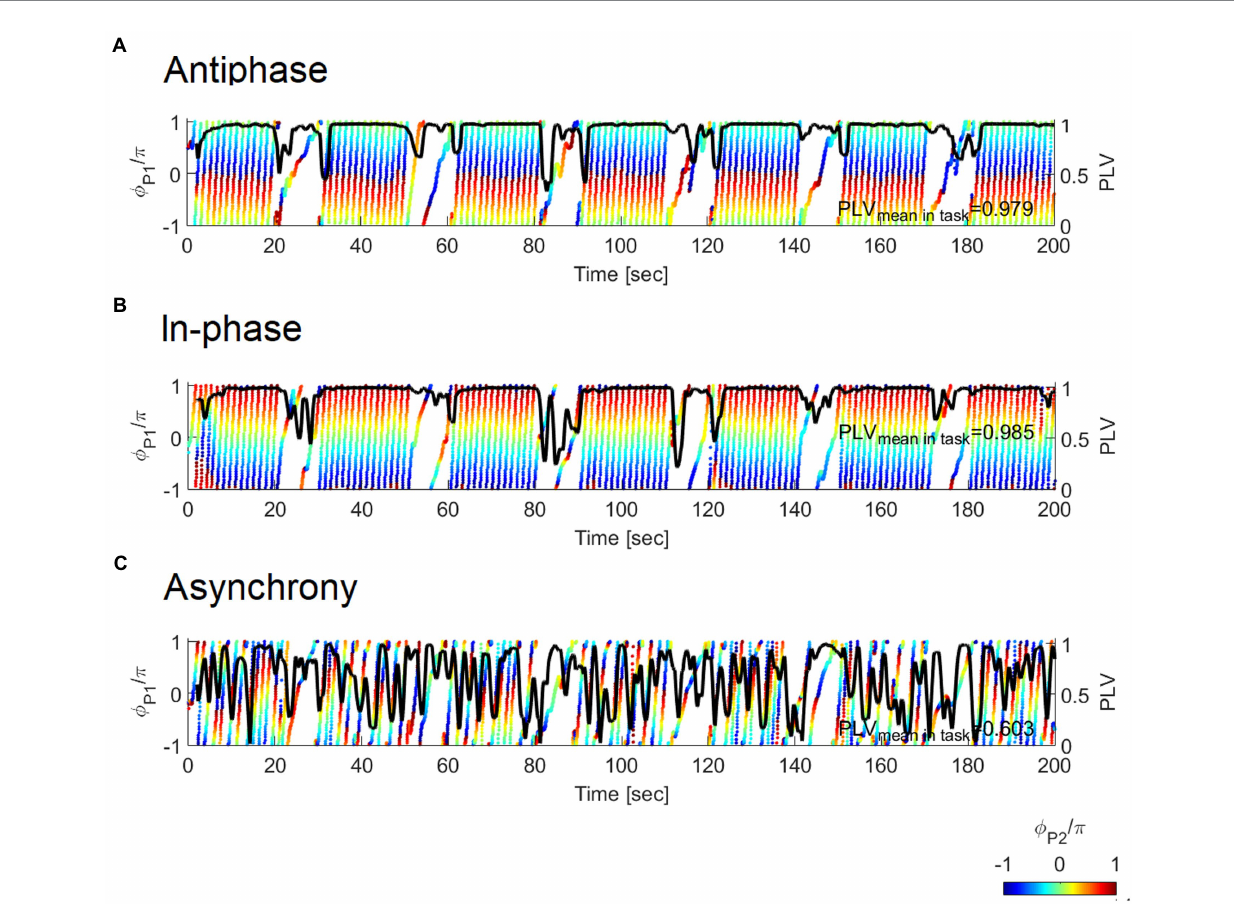
FIGURE 2 Example of the relative phase and PLV between the handclap motions of the participant (P1) and confederate (P2) in the (A) Antiphase, (B) In-phase, and (C) Asynchrony conditions. The color synchrogram illustrates a relative phase between the two types of participants. Colored dots represent the instantaneous phase of P1( P1 φ ). The diagonal arrays of dots in the plot demonstrate the increase of P1 φ from −π to π . The color on dots shows the instantaneous phase of P2( P2 φ ) as P1 φ gains 2 π from −π to π . Here −π , 0, and π are displayed in blue, green, and red, respectively. Phase synchronization is represented by horizontal lines of the same color band. PLV, indicated by the thick black line, is stable with a high value across trials in both the antiphase and in-phase synchrony conditions but unstable in the asynchrony